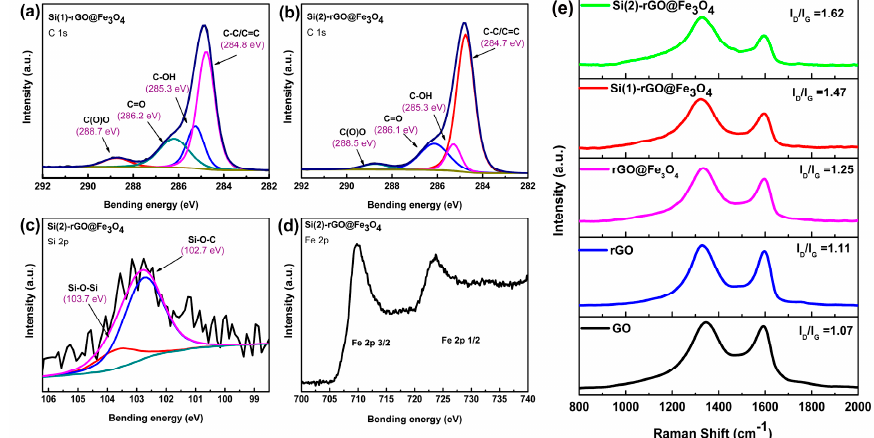
Figure 3. XPS spectra of Si-modified rGO@Fe 3 O 4 : High-resolution C1s spectra of ( a ) Si(1)-rGO@Fe 3 O 4 , ( b )Si(2)-rGO@Fe 3 O 4 , ( c ) high resolution Si2p spectrum of Si(2)-rGO@Fe 3 O 4 , and ( d ) Fe2p spectrum of Si(2)-rGO@Fe 3 O 4 . ( e ) Raman spectra of all the samples.